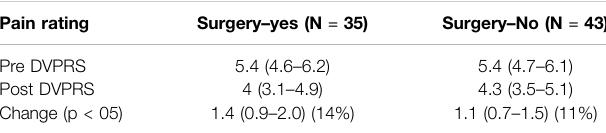
TABLE 6 | Pain Rating (DVPRS 0 – 10) by Recent Surgery Designation Pre and Post VR session. Pain rating